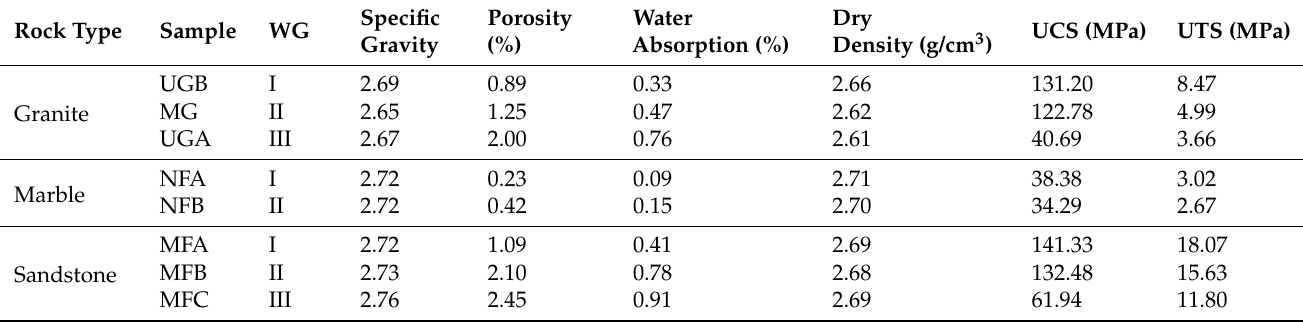
Table 4. Weathering grades and calculated average values of strength and physical properties of the studied